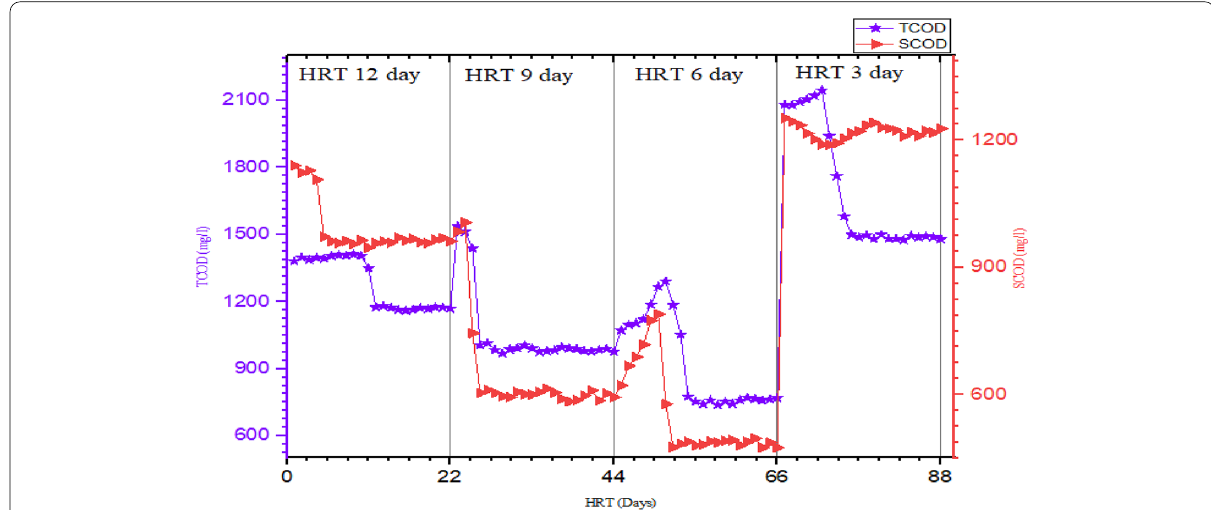
Fig.5 Trends/variation of COD and TCOD in MR at different OLR/HRT